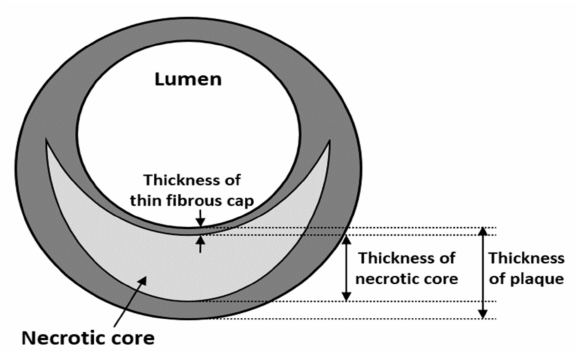
Figure 3. Thicknesses of the thin fibrous cap and necrotic core